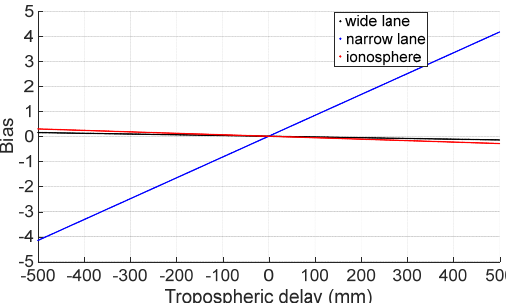
Figure 7. Effect of neglecting tropospheric delay on wide ‐ lane ambiguity resolution.